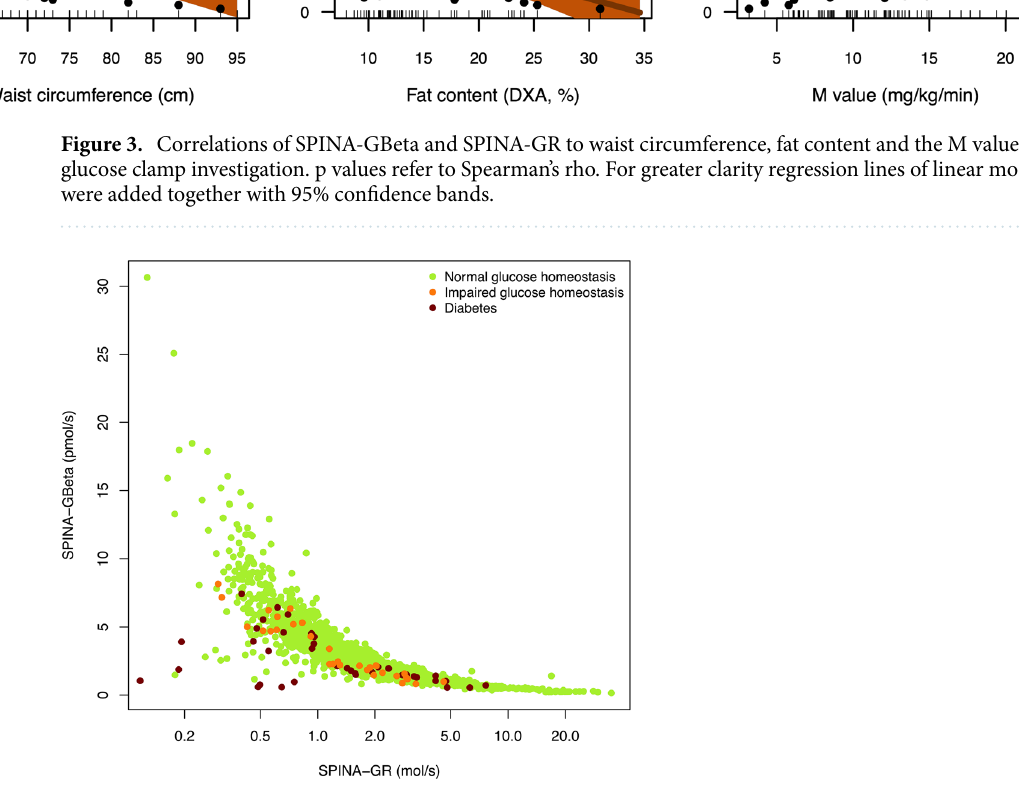
Figure 4. Plot of SPINA-GBeta against SPINA-GR, suggesting a compensatory rise of beta cell function in the case of declining insulin sensitivity in subjects with normal glucose homeostasis (green dots). This ability of beta cell compensation if partly lost in subjects with prediabetes (orange dots) or diabetes (red